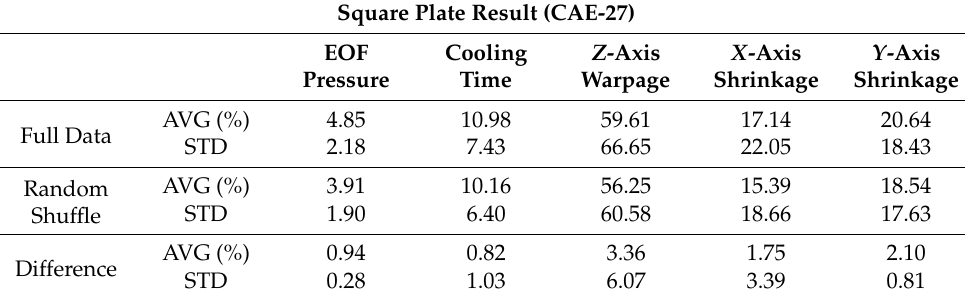
Table 8. Training results for the square flat model (CAE-27).